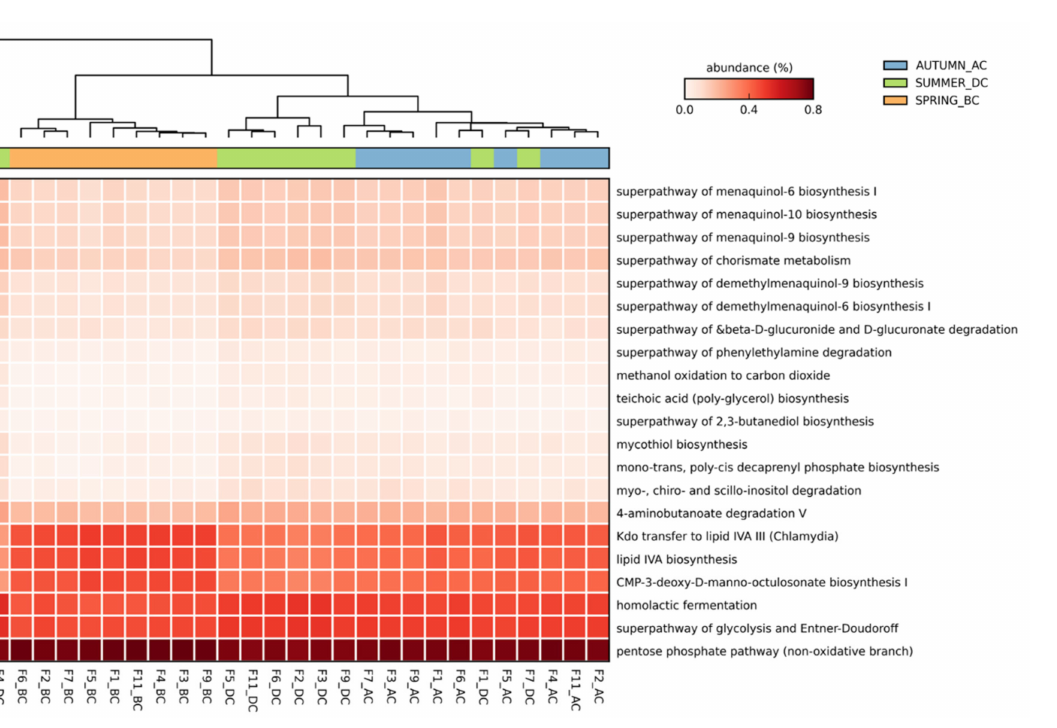
Figure 7. Heatmap of the predicted functional profile for nine fields across three seasons: Spring_ before cultivation (BC), Summer_during cultivation (DC), Autumn_after cultivation (AC) analysed using the STAMP software. The key shows the % relative abundances for p -value ≤ 0.05 and effect size > 0.7 (n =